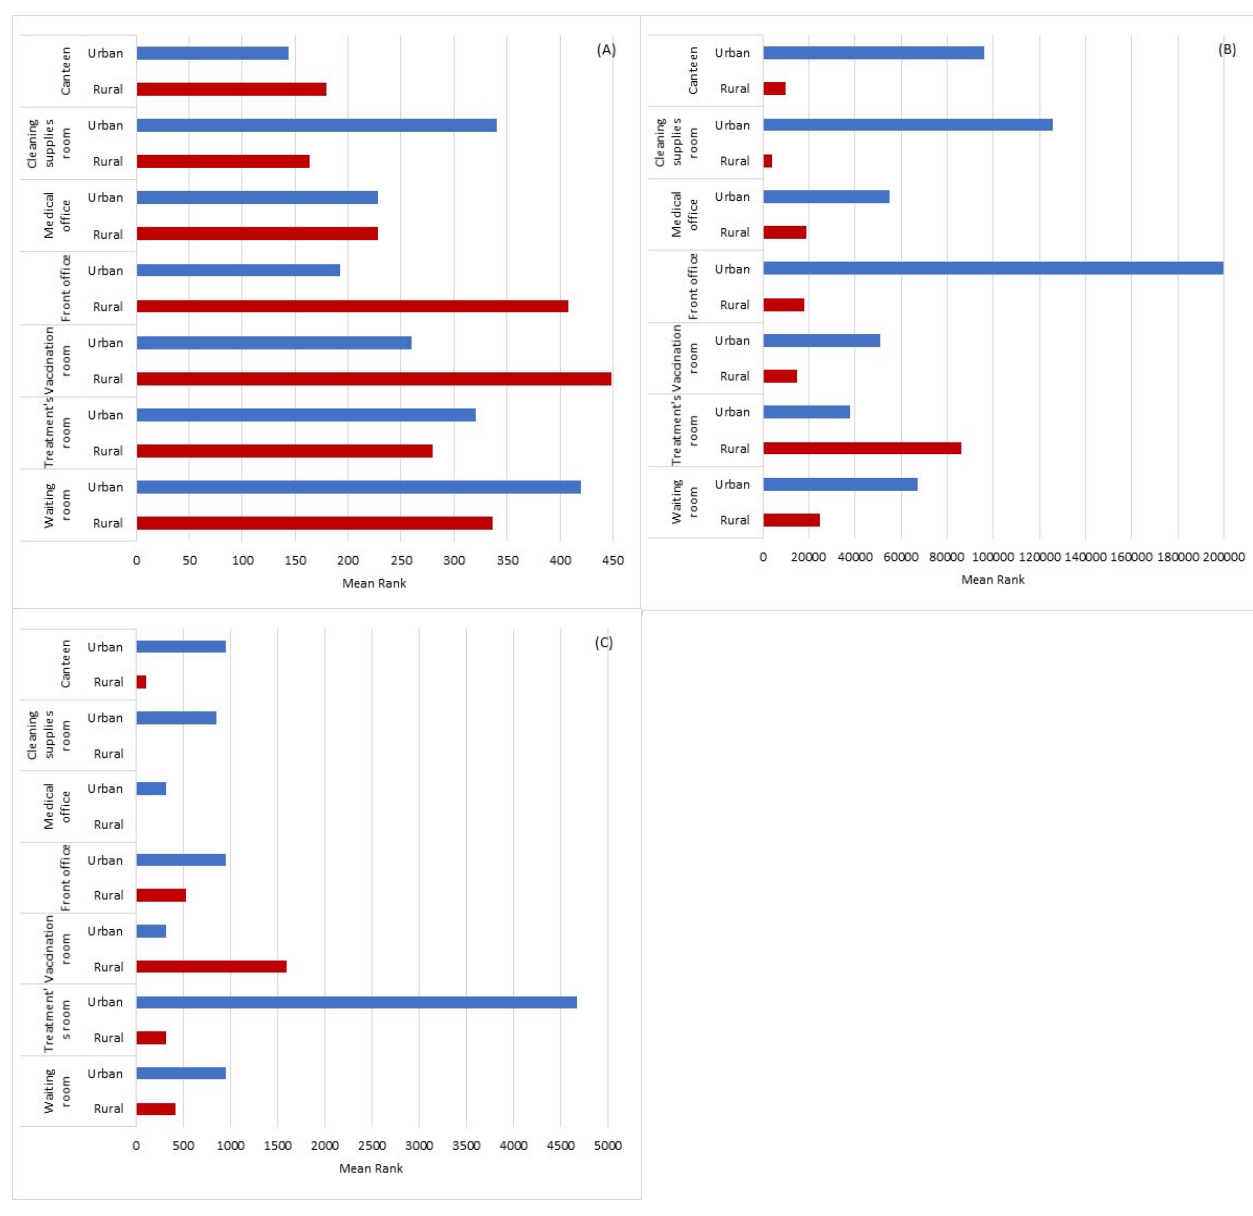
Figure 1. Total aerobic mesophilic bacteria in air—CFU.m − 3 ( A ), surfaces—CFU.m − 2 ( B ) and EDC—CFU.m − 2 ( C ) for sampled areas from rural and urban PHCC: Mann-Whitney test results.